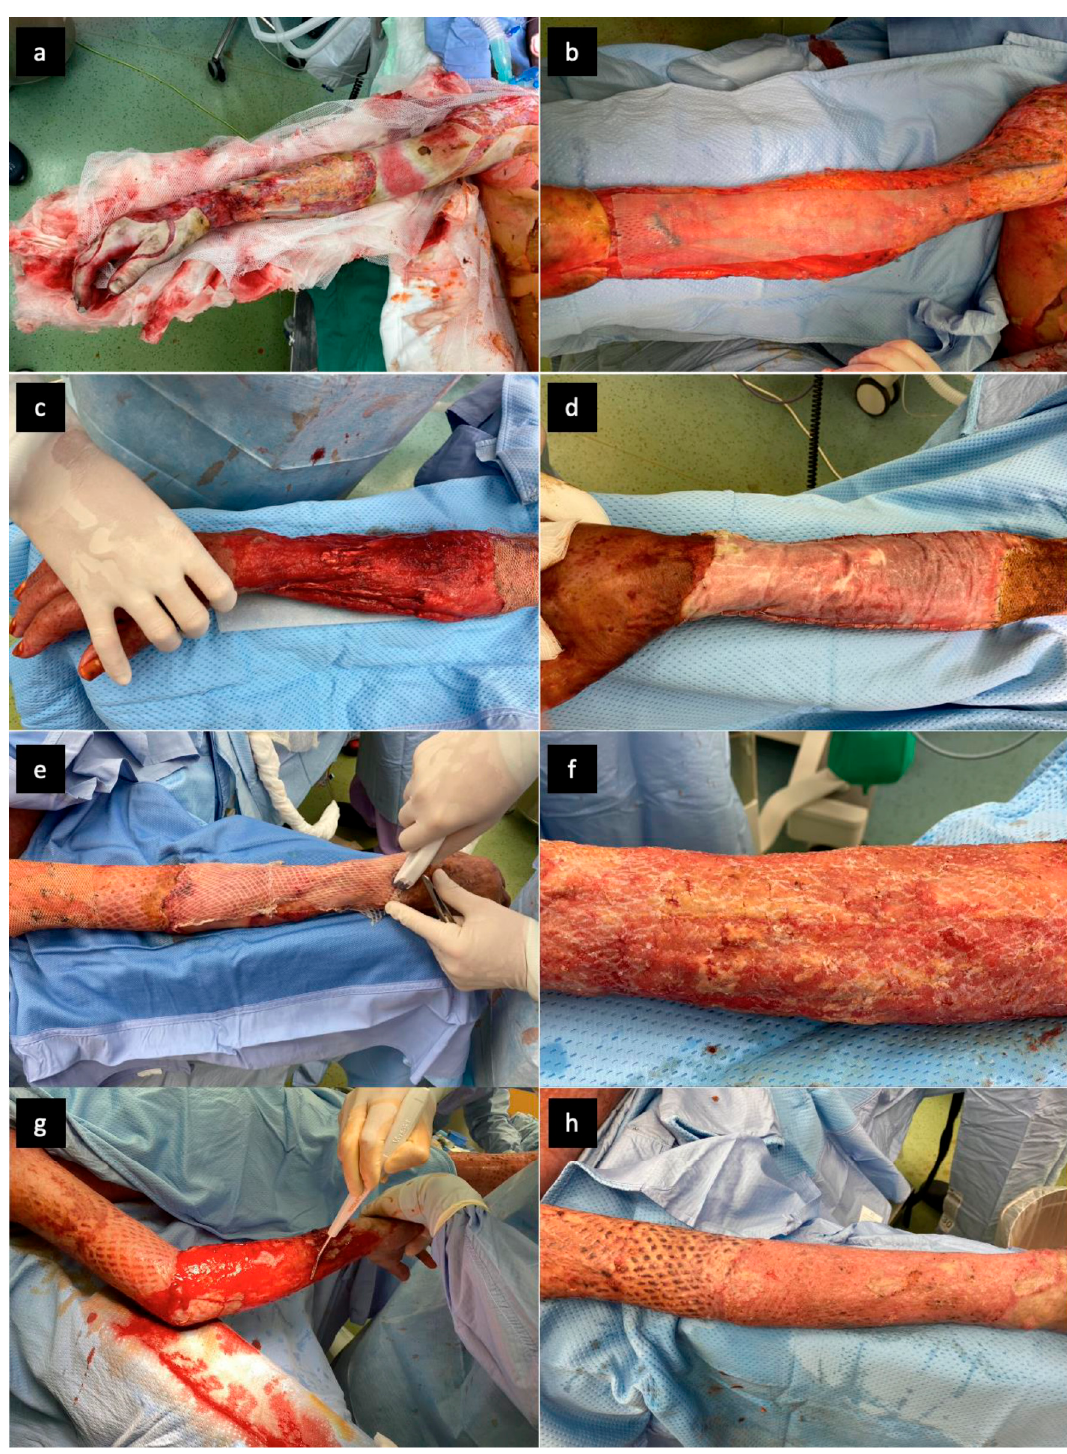
Figure 1. ( a ) Burn areas in the region of the upper right extremity on Day 2 after the injury, after surgical necrectomy; ( b ) following necrectomy, skin allograft was applied on the wound; ( c ) after wound bed preparation, a bi-layered dermal substitute (Nevelia ® , Symatese Aesthetic, Chaponost, France) was applied; ( d ) the dermal substitute was fastened by clips and neovascularization gradually progressed; ( e ) then, autologous STSGs were applied; ( f ) loss of STSGs due to fungal infection; ( g ) hydrosurgical debridement prior to the next attempt for skin transplantation; ( h ) and healed STSG.